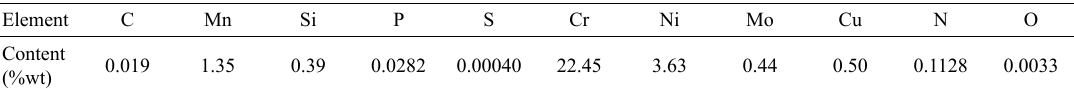
Table 1: Chemical composition of the base metal Element C Mn Si